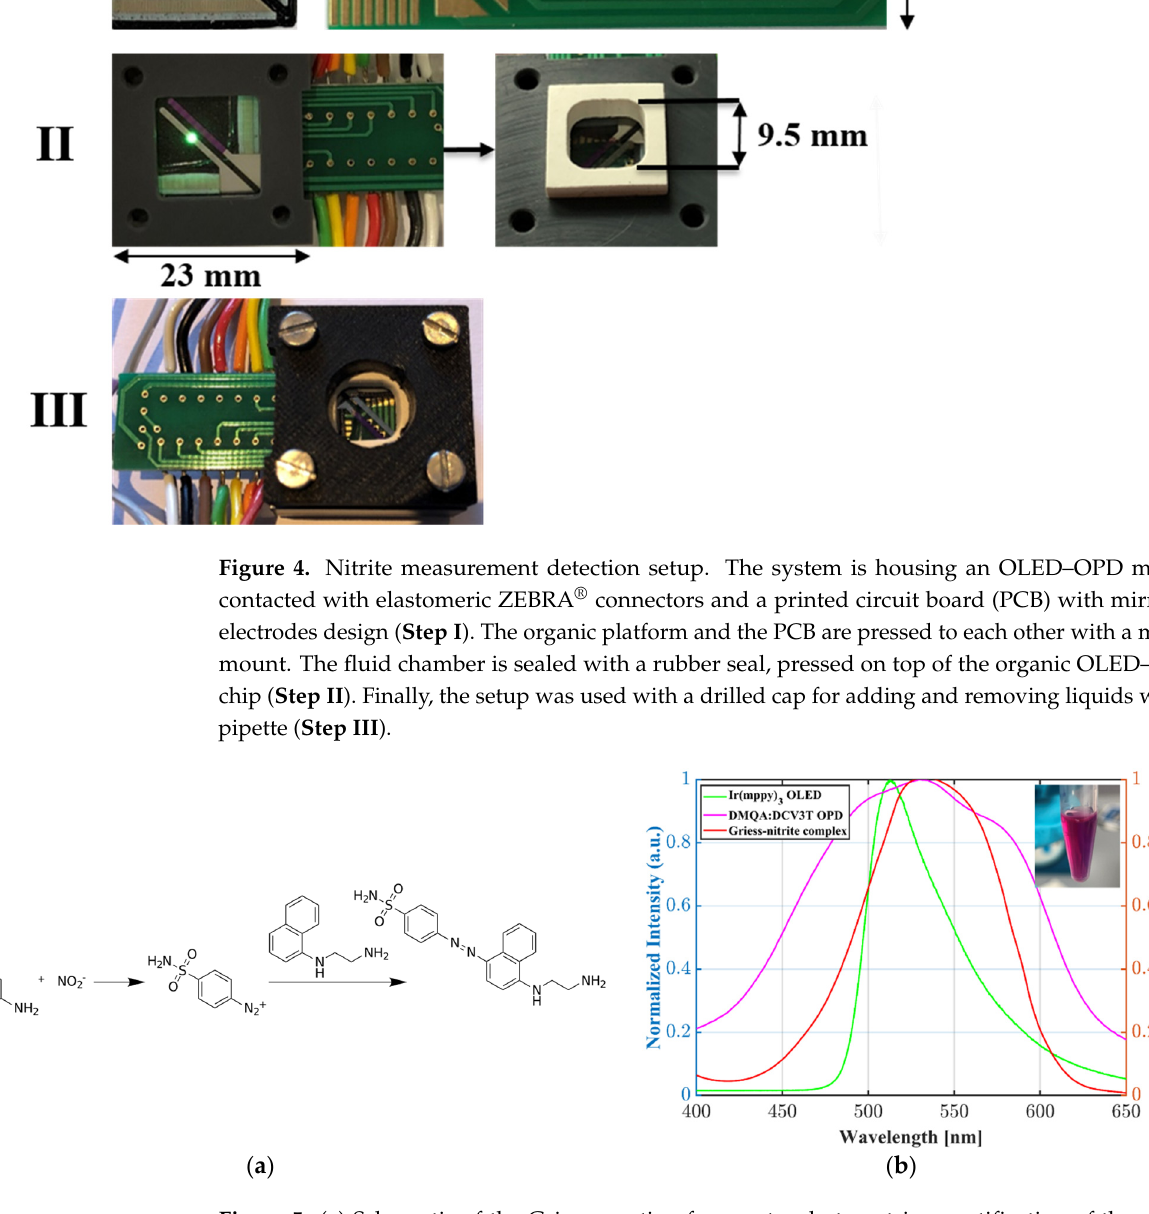
Figure 5. ( a ) Schematic of the Griess reaction for spectrophotometric quantification of the nitrite concentration; ( b ) overview of the OLED emission spectrum as well as the absorption spectra of the OPD and the Griess-reaction-based azo dye. The chosen organic composition of the OLED–OPD system has overlapping emission and absorbance spectra for the highest nitrite sensitivity. The inset shows, as an example, strong absorbance at around 540 nm for a nitrite standard sample of 30 mg/L. As depicted in Figure 5b, we chose the organic composition of the OLED–OPD matrix The nitrite sensing experiments were performed with nitrite standard solutions at for the highest absorbance of the green OLED light on the OPD. Due to total internal re- room temperature prepared 10 min prior to use. Although the azo dye formation was near flection (TIR) the light propagated partly inside the glass substrate and induced photo- instantaneous, according to the datasheet the reaction was accomplished after an incubation current in the OPD, since the OLED is an extended device with isotropic emission. The time of 10 min. The signal was stable for 1 h after adding the reagents. Brizzolari et